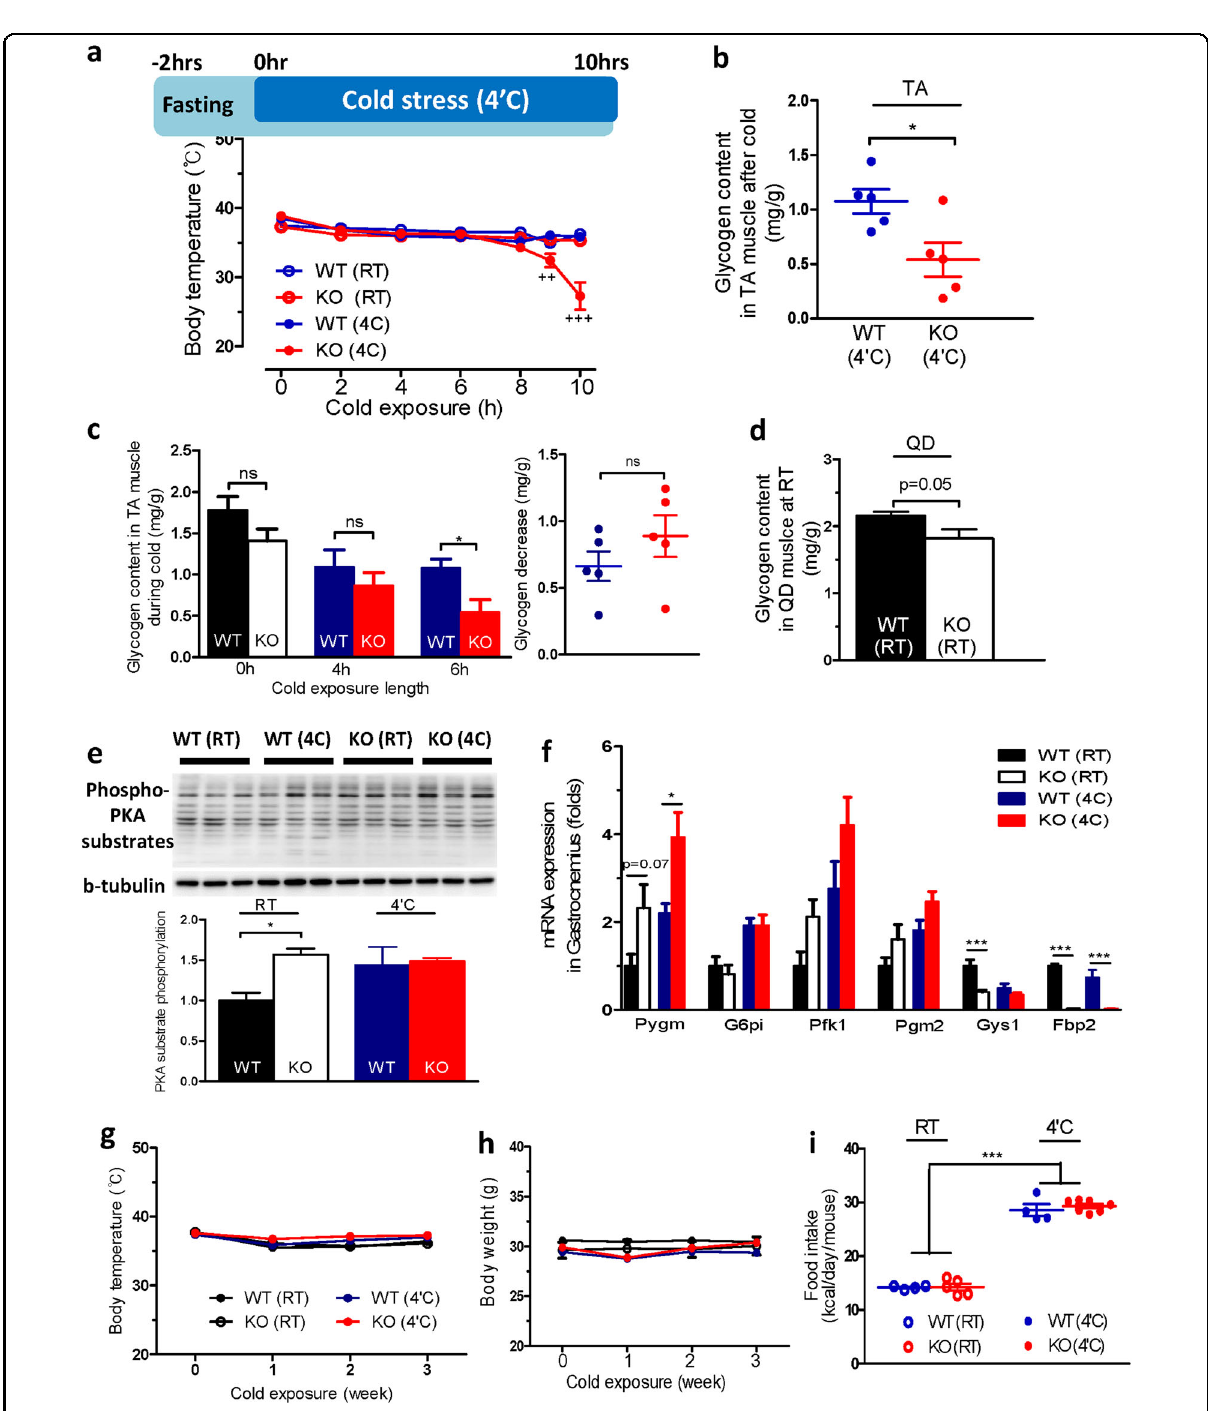
Fig. 3 Fbp2 was important for cold tolerance during fasting conditions. a Body temperature changes in WT and Fbp2 KO mice in cold stress experiments, n = 4 for the RT group; n = 8 for the cold group. b Glycogen content in the TA and QD muscles of WT and Fbp2 KO mice after cold stress experiments. n = 5 per group. c Glycogen content depending on cold exposure time (left) and glycogen content decrease after cold stress experiments (right) in the TA muscle of WT and Fbp2 KO mice. n = 5 per group. d Glycogen content in the QD muscle of WT and Fbp2 KO mice at room temperature. n = 5 per group. e Immunoblotting results of PKA substrate phosphorylation in WT and Fbp2 KO mice in cold stress experiments. n = 5 per group. f Gene expression analysis in the GAS muscle of WT and Fbp2 KO mice after cold stress. n = 4 – 6 per group. g Body temperature change, h body weight change, and i daily food intake of WT and Fbp2 KO mice in cold stress experiments for 3 weeks. n = 4 – 7 per group. h hour, TA tibialis anterior, QD quadriceps, PKA protein kinase A, Pygm glycogen phosphorylase, muscle associated, G6pi glucose-6-phosphate isomerase, Pfk1 phosphofructokinase 1, Pgm2 phosphoglucomutase 2, Gys1 glycogen synthase 1. Data are expressed as the mean ± SEM. * P < 0.05, ** P < 0.01, *** P < 0.001 by Student ’ s t -test. ++ P < 0.01, +++ P < 0.001 by two-way ANOVA with post hoc analysis for a . ns nonsigni fi